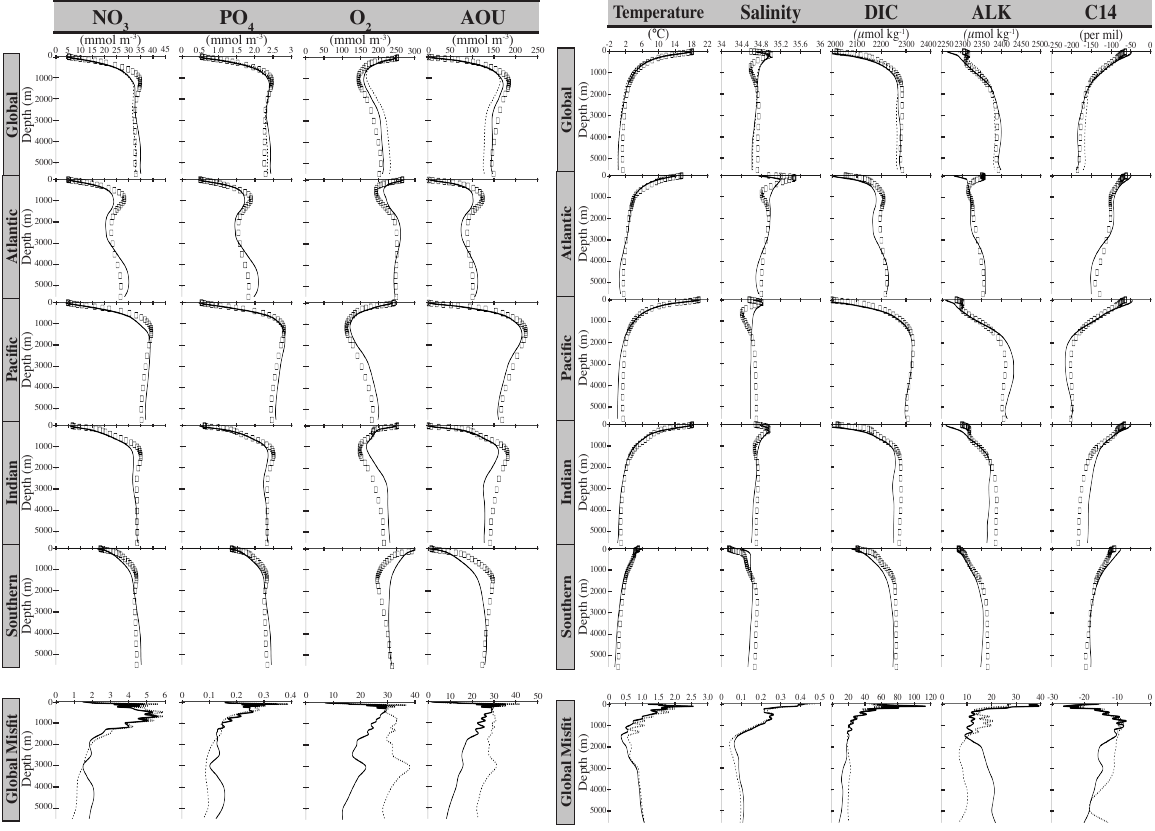
Fig. 4. Top panels: Global and basin-wide averaged vertical profiles of various model tracers (solid lines) compared with observations (squares) and the previous model formulation (dotted lines, global comparisons only). Bottom panel: The misfits between the globally averaged vertical model profiles (solid line: new formulation, dotted line: previous formulation) and